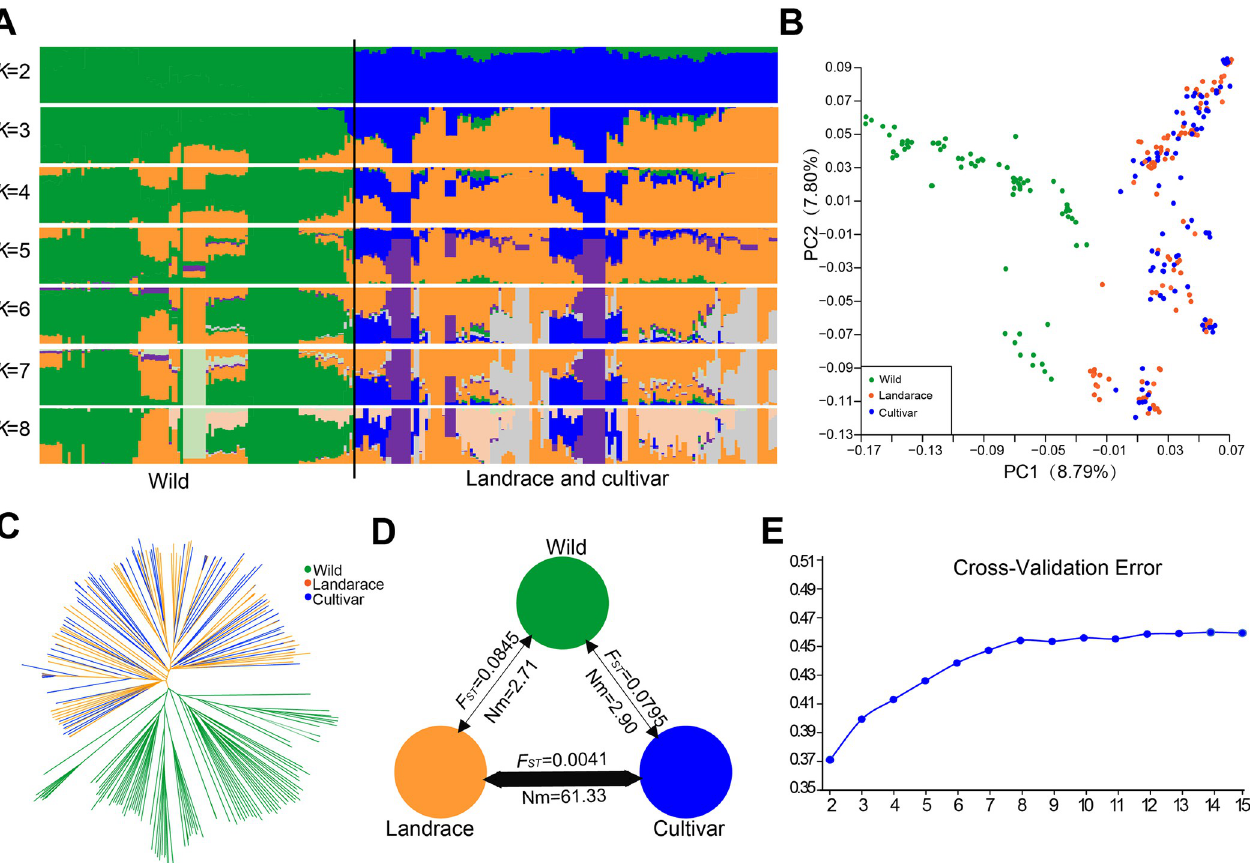
Fig 2. Population analysis of 254 Persian walnuts ( Juglans regia ). (A) Population structure analysis of ancestry components for 254 Persian walnuts ( Juglans regia ). Each color corresponds to a single population as noted. Each accession is represented by a vertical bar. The Y-axis refers to the proportion of the genetic background, and the height of each line with different colors represents the probability of an accession belonging to a different genetic background. (B) PCA of 254 Persian walnuts ( Juglans regia ). The first two principal components were accounting for 16.59% of variations. (C) A neighbor-joining tree of 254 walnut accessions. (D) D statistics for comparisons among Persian walnut groups. The black arrow line indicates the Z-score between the two groups. The thickness of the line indicates the value of Nm. (E) Estimated Delta K of possible clusters (k) from 2 to